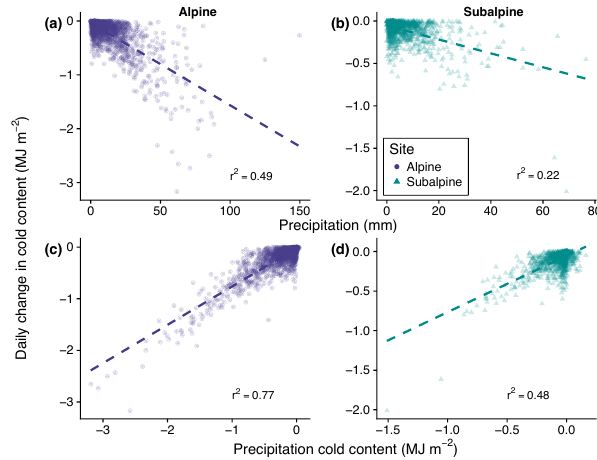
Figure 9. Simulated daily change in cold content plotted against daily precipitation in the alpine (a) and subalpine (b) , and cold con- tent from precipitation in the alpine (c) and subalpine (d)